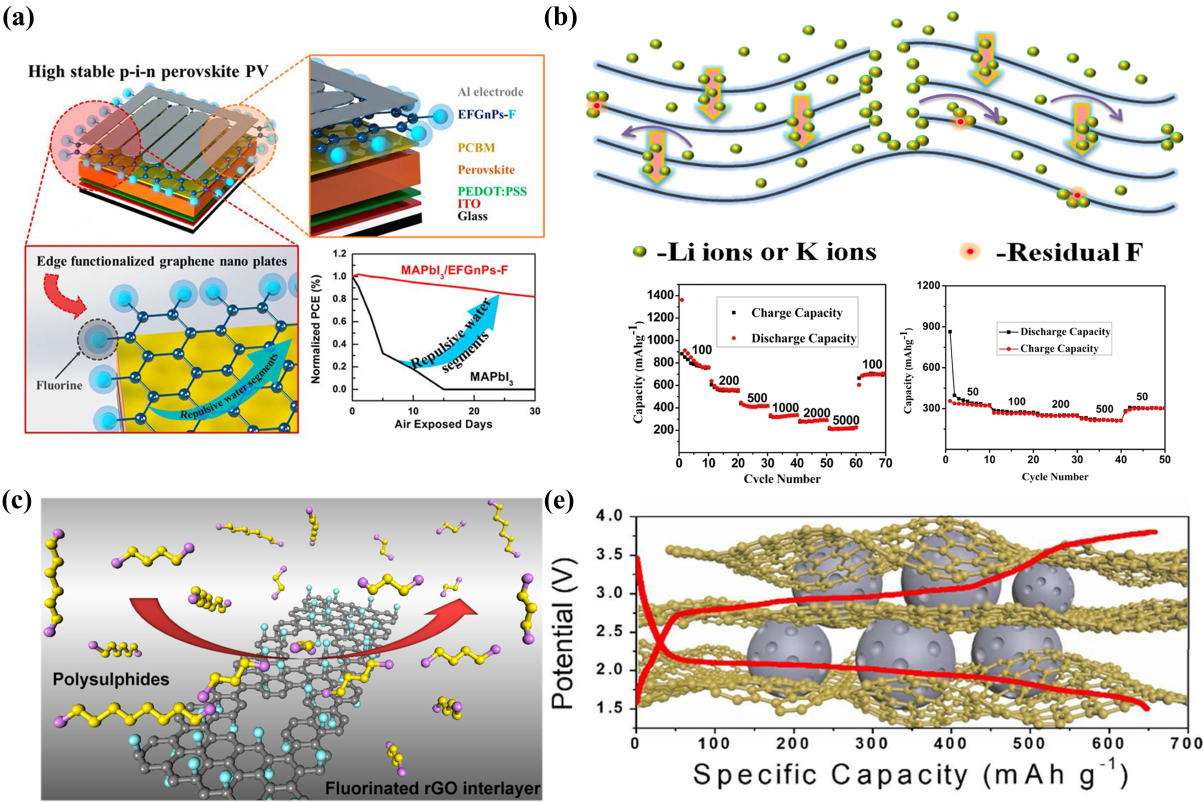
Figure 4: (a) Schematic of EFGnPs-F for highly stable inverted perovskite solar cells. Reprinted with permission from [96]. (b) Schematic of FFGF for lithium/potassium storage and the corresponding rate performance. Reprinted with permission from [97]. (c) Schematic of F-rGO as an interlayer in Li-S batteries. Reprinted with permission from [98]. (d) The first discharge/charge curves of Na/F-MCMB cell at a rate of 0.05C. Reprinted with permission from